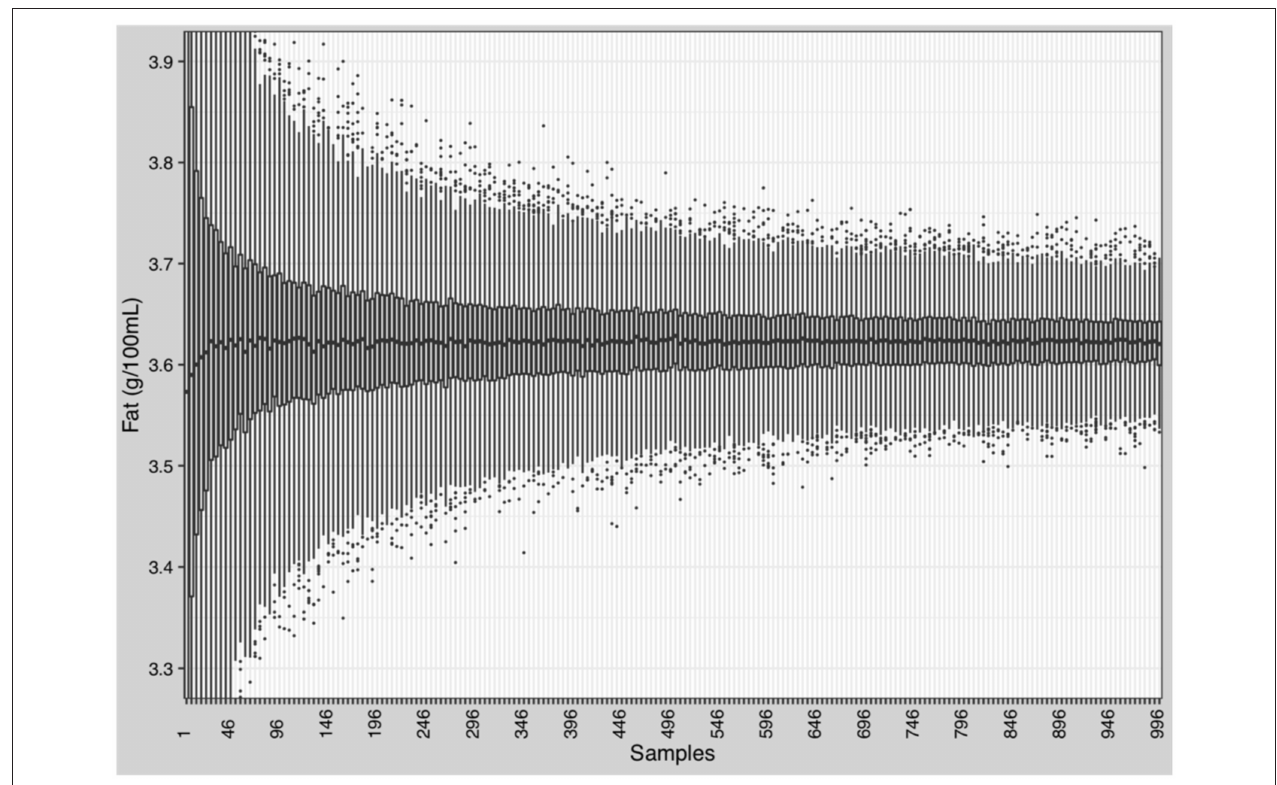
FIGURE 9 | Reduction of the variation of macronutrients and energy in native breast milk. Randomly selection and batching of breast milk samples by stepwise increase from 1 to 996 samples in increments of 5. Each step was repeated 1,000 times and mean and standard deviation were calculated.